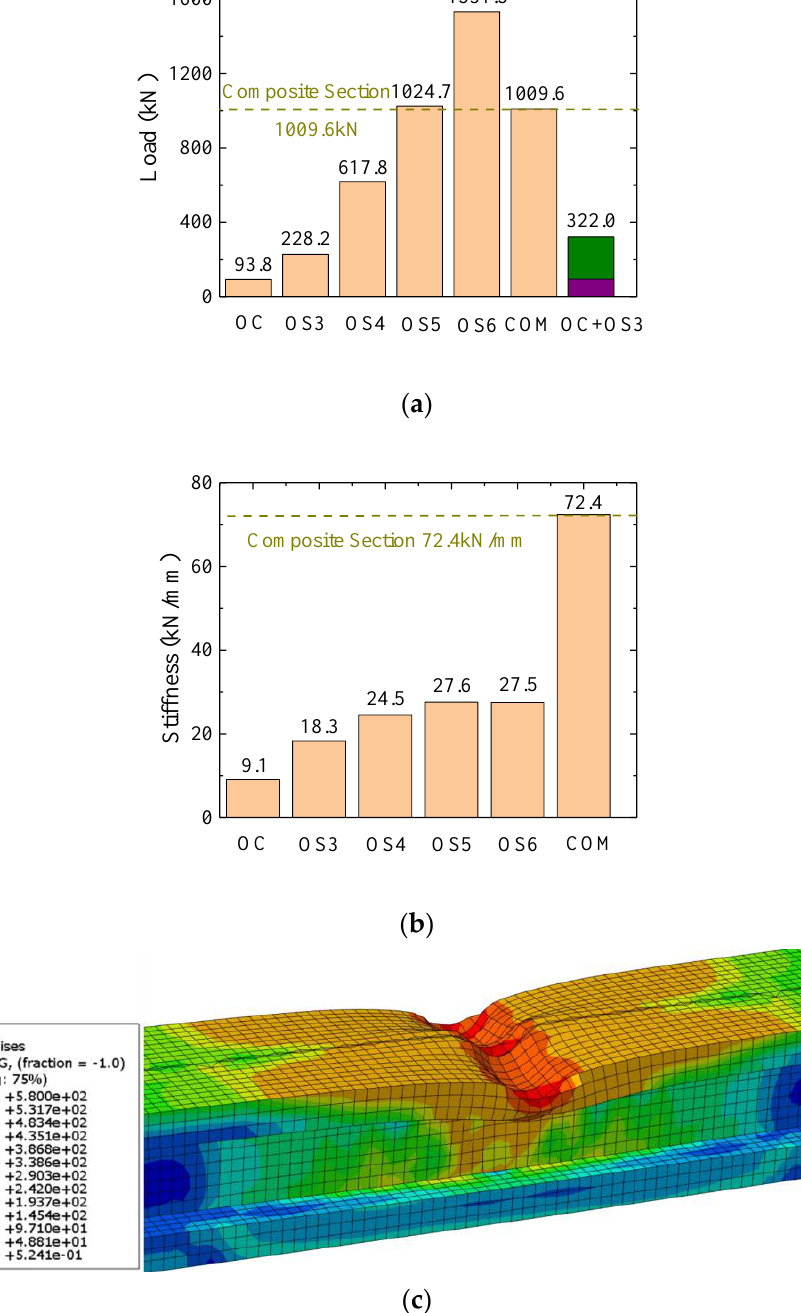
Figure 18. Influence of composite action on flexural behavior. ( a ) Influence of composite action on load-carrying capacity; ( b ) influence of composite action on initial stiffness; ( c ) failure mode of specimen OS6.